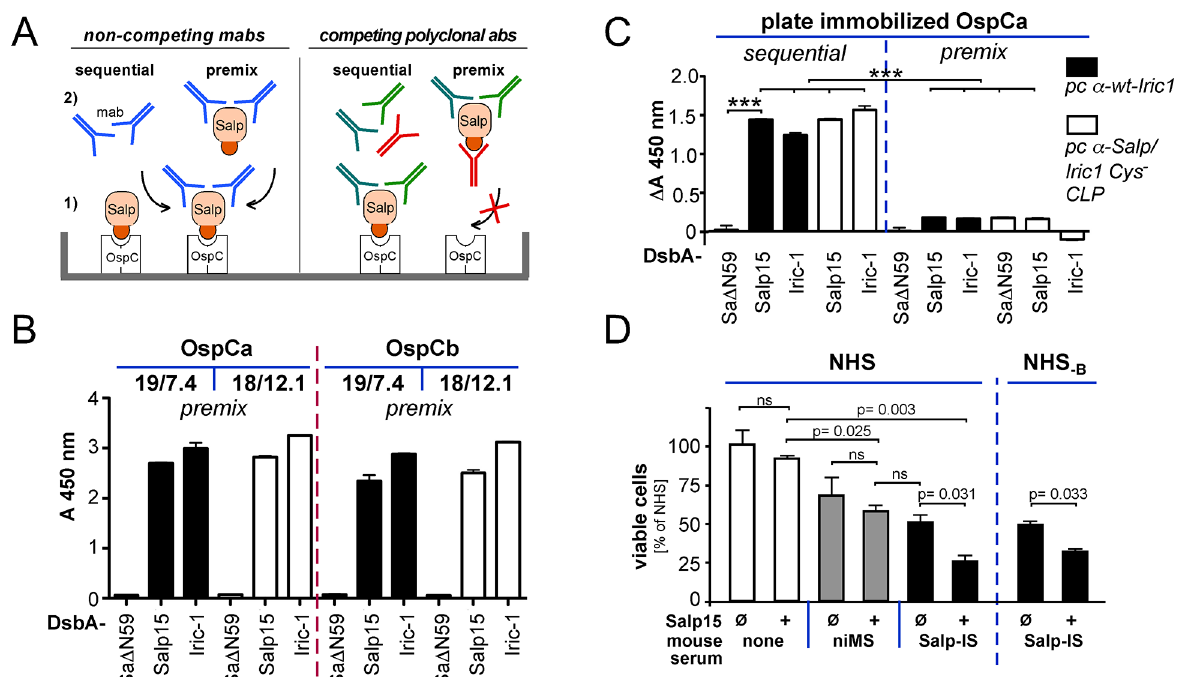
Fig 9. In vitro evidence for anti-borrelial activity of vaccination-induced anti-Salp15 antibodies. (A-C) Interference with the Salp15-OspC interaction. (A) Competitive ELISA scheme. In the usual sequential procedure ( left ) Salp15 can (1) bind via its interaction region (red) to immobilized OspC. Bound Salp15 can then be detected (2) using anti-Salp15 mabs 19/7.4 and 18/12.1 [10]. As the mab epitopes are outside the OspC binding region, preincubation (premix) of Salp15 with the mabs should not interfere with OspC binding ( left part ). If the vaccination induced polyclonal IS contain antibodies to the OspC binding region (in red), the sequential format should still allow Salp15 — OspC binding; however, in the premix format such antibodies would compete with OspC binding. (B) Assay validation using non-competing mabs. DsbA-fused Salp15, Iric-1 or non-OspC binding Sa Δ N59 protein as negative control were premixed with excess mab 19/7.4 or 18/12.1, then the mixtures were added to plate-immobilized B . burgdorferi OspCa or OspCb. Bound mab complexes were detected using a secondary anti-mouse-PO conjugate. As expected, no interference was observed. (C) Antibodies in vaccination-induced IS compete with OspC binding. In the sequential format, the polyclonal IS to wt-Iric-1 (pc α -wt-Iric1) and pooled IS to CLPs presenting Cys-free Salp15 and Iric-1 (pc α -Salp/Iric Cys - CLP) gave strong signals upon OspCa-mediated binding of DsbA-fused wt-Salp15 and wt-Iric-1. In contrast, signals were markedly reduced in the premix format. Comparable results were obtained for OspCb, and B . afzelii OspC A3 and YU (S6 Fig). (D) Anti-Salp15 antibodies in the presence of Salp15 enhance killing of borreliae by human complement. B313 borreliae were preincubated in the absence or presence of recombinant H6-Salp15 with either anti-Salp15-specific mouse IS (Salp-IS) or non-immune mouse serum (niMS), and thereafter in 25% (v/v) normal human serum (NHS). Cell counts were determined in triplicate by a fluorescence-based survival assay [38] and normalized to the mean value obtained in NHS without any additives (set to 100%); error bars denote SEM. Note that the simultaneous presence of both Salp15 and anti-Salp15 antibodies (Salp-IS + Salp) caused a further, significant drop in viability (p = 0.031) compared to niMS ± Salp. Comparable results with factor B depleted NHS (NHS -B ) confirmed the antibody-dependence of the effect. See text for further controls and experimental